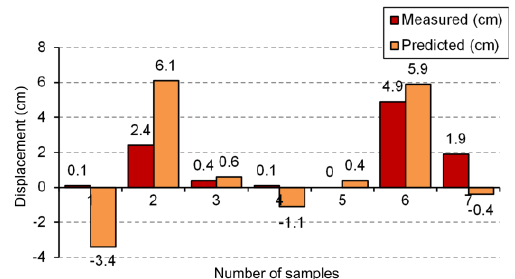
Figure 4. Judgment among predicted and measured deformation for testing data locations